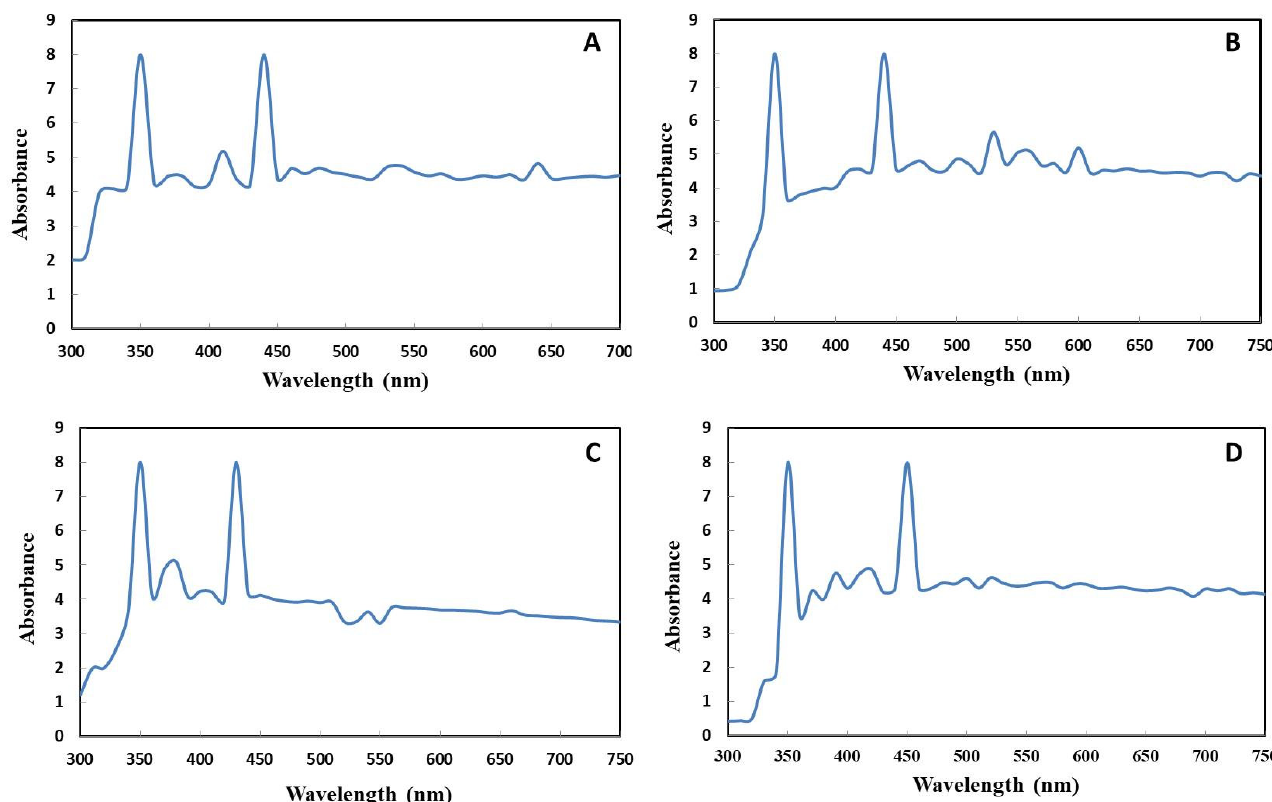
Figure 3. UV–visible spectra. ( A ) Control bimetallic nanoparticles of Ag–ZnO (0.1/0.1). ( B ) UV-C mediated bimetallic nanoparticles of Ag–ZnO (0.1/0.1). ( C ) Control bimetallic nanoparticles of Ag–ZnO (0.1/0.5). ( D ) UV-C mediated bimetallic nanoparticles of Ag–ZnO (0.1/0.5).